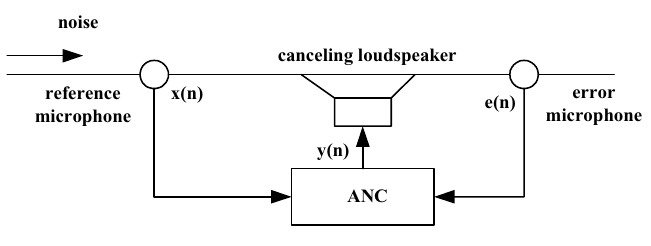
Fig. 1. Feedforward ANC system in a